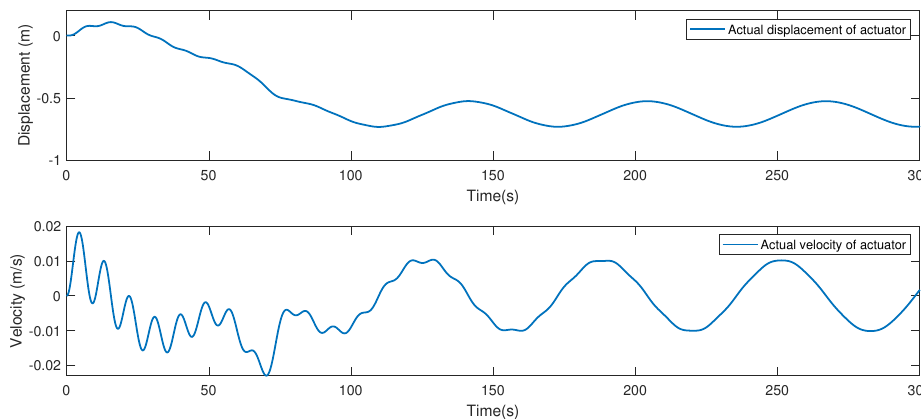
Figure 18. The position and velocity trajectory of the SEA